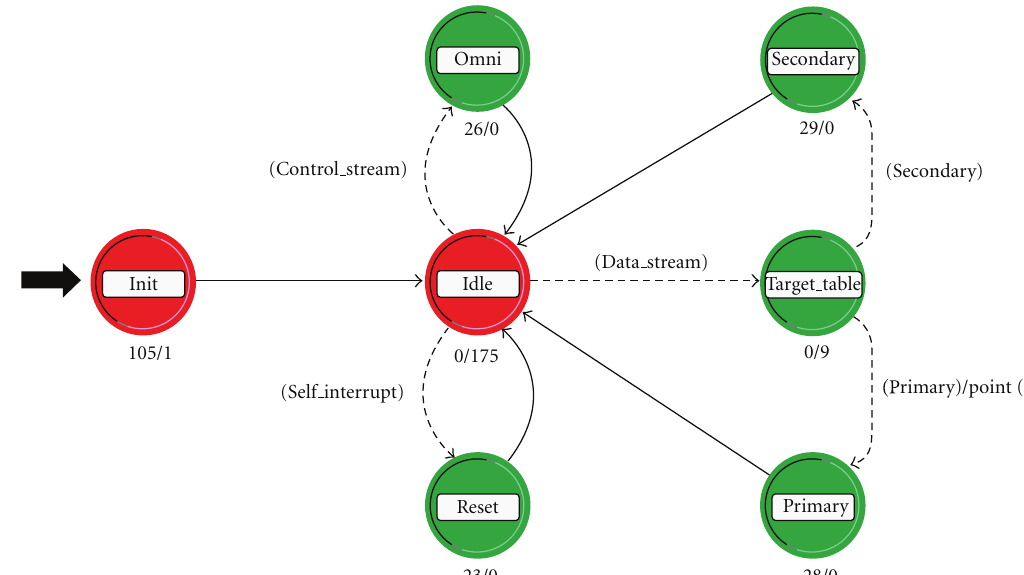
Figure 6: OPNET process model of UAV SUB MAC.